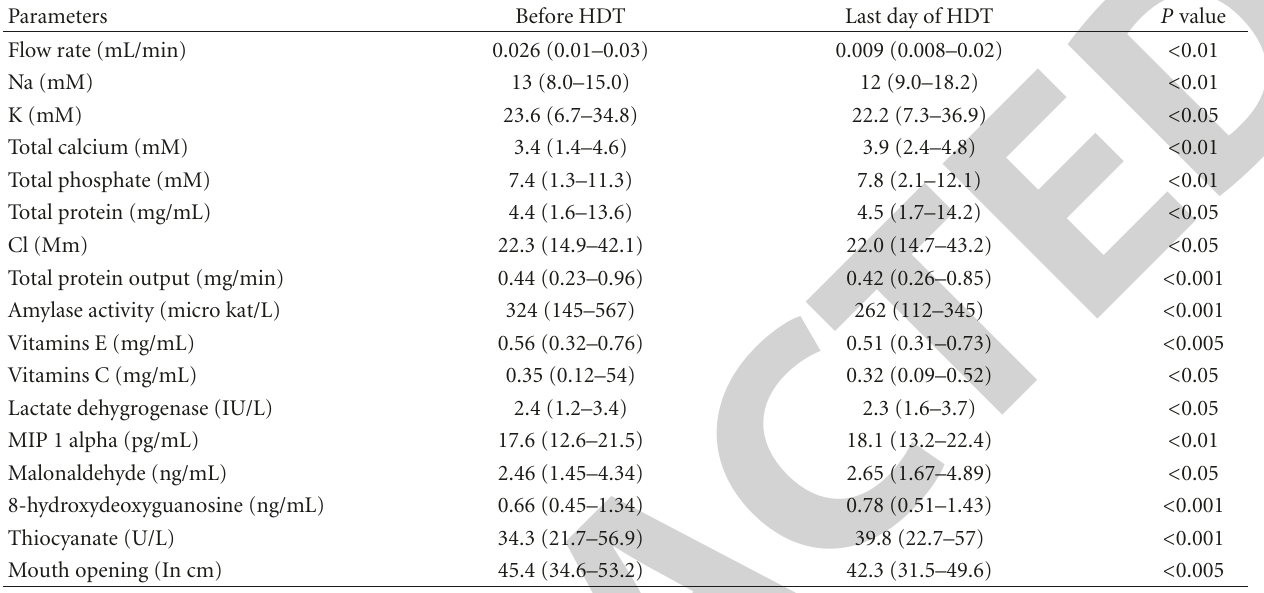
Table 1: The median (range) unstimulated salivary whole flow rate, compositions, biomarkers (sodium, potassium, calcium, phosphate, protein, lactate dehygrogenase, MIP 1 alpha, malonaldehyde, 8-hydroxydeoxyguanosine, thiocyanate, amylase activity, vitamins E, C), and mouth opening before and during last day of HDT in 10 healthy persons.